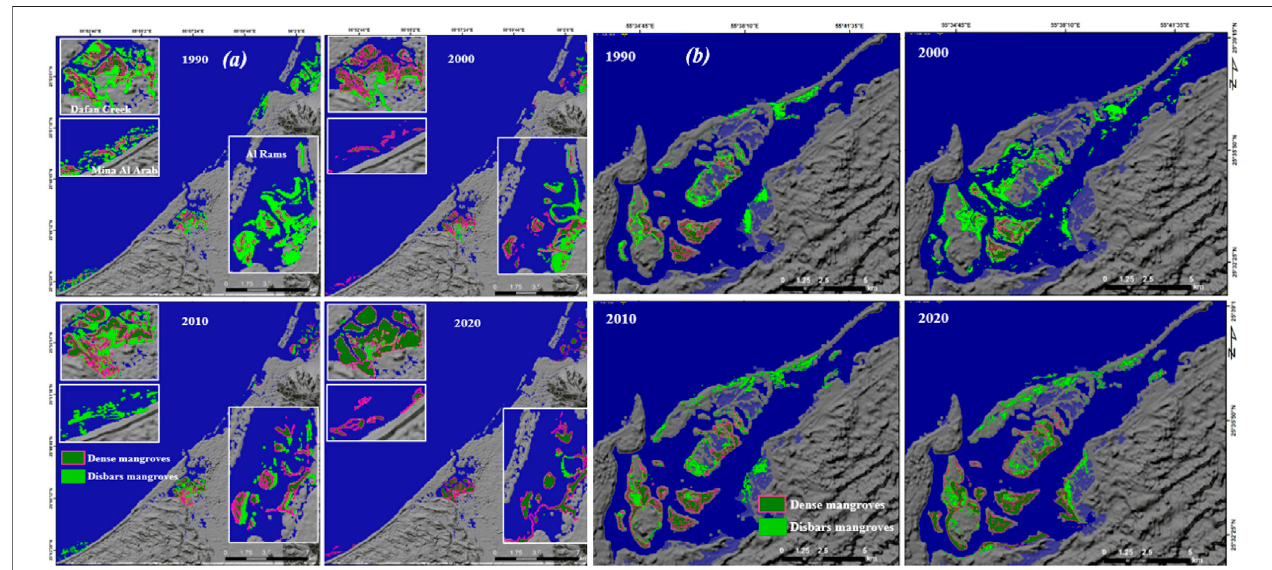
FIGURE 6 | Spatiotemporal variation of mangrove forests on the coastal area of RAK (A) and Umm Al Quwain (B) for the years from 1990 to 2020.